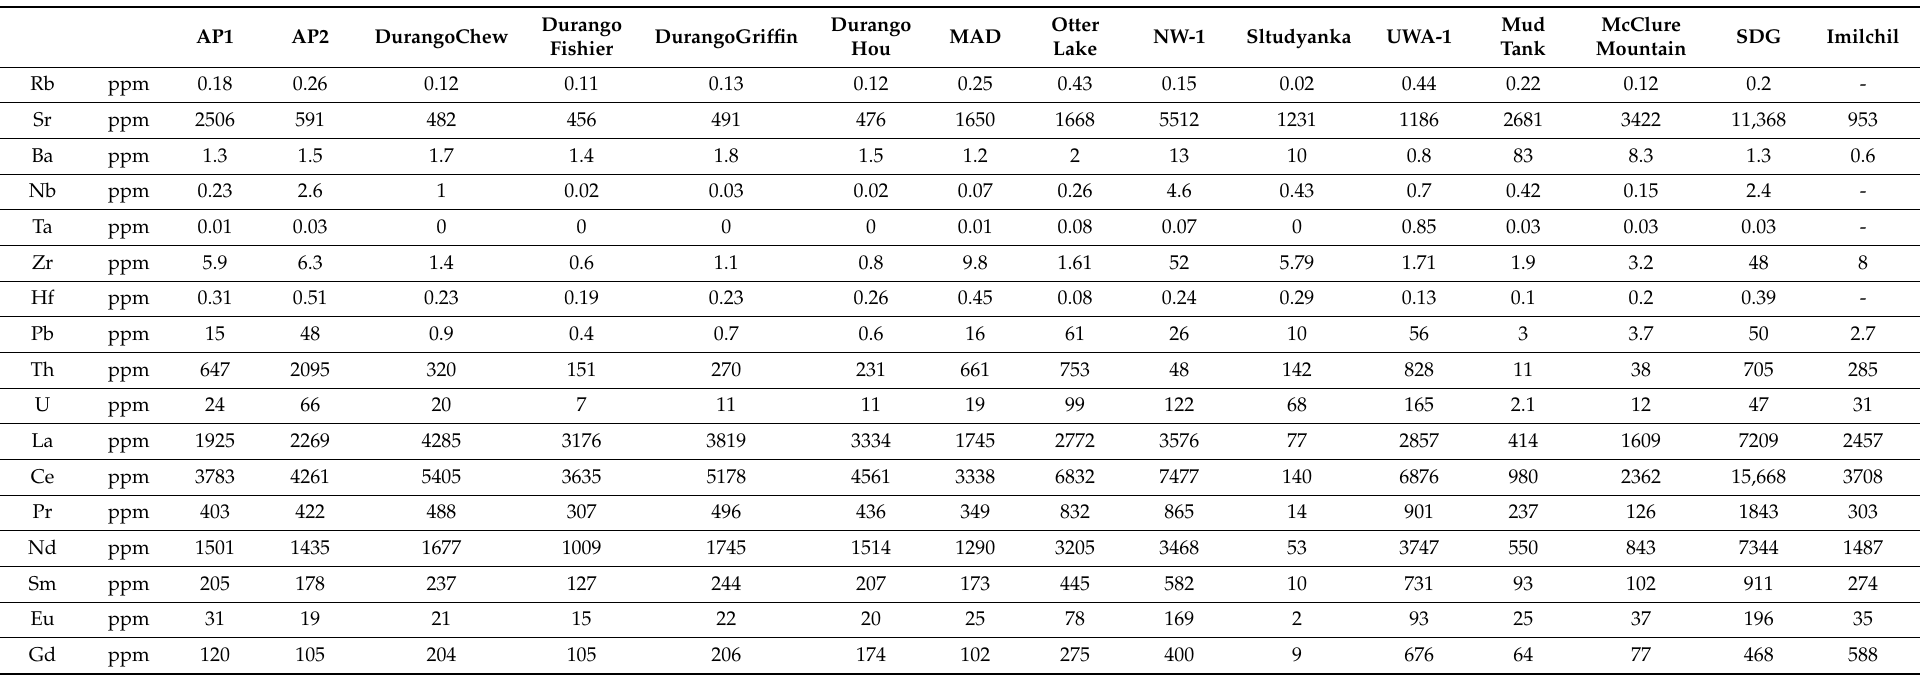
Table 5. Chemical composition and structural formula of Moroccan apatite, analysed by LA-ICP-MS. Data derived from